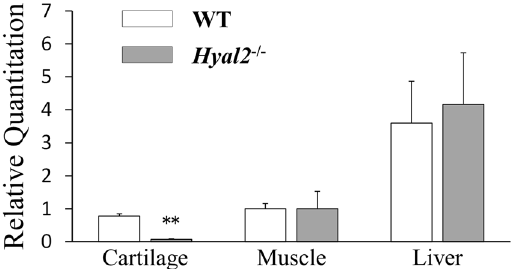
Figure 2. Hyal2 mRNA expression in cartilage, muscle and liver of 9-month-old male Hyal2 − / − and WT mice. Expression levels of Hyal2 mRNA were determined with RT-PCR, and normalized with those of Gapdh. (n = 6, respectively). ** P < 0.01.